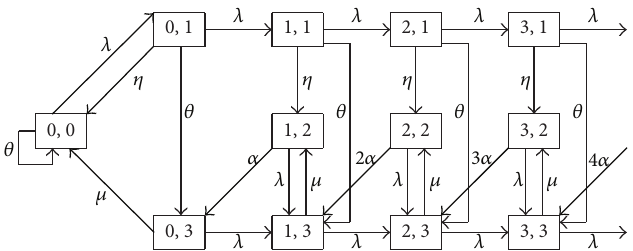
Figure 1: State transition rate diagram of the